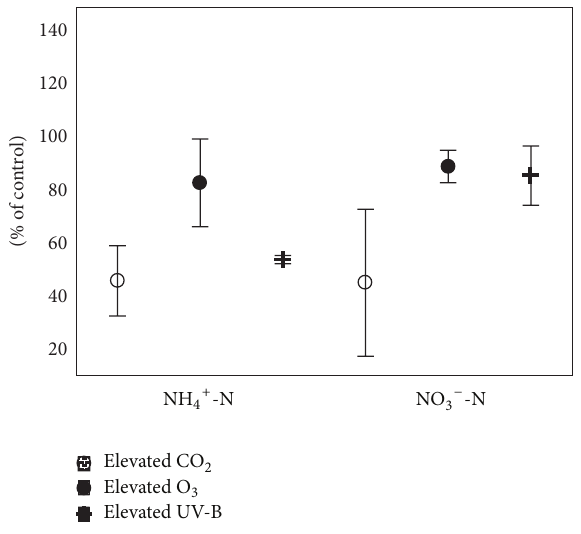
Figure 3: Effect of elevated CO 2 , O 3 , and UV-B on NH 4+ -N and NO 3− -N content in soil (recalculated from [16, 27, 33, 41]). The values are expressed in % of control = 100% which represent ambient CO 2 , O 3 , or UV-B (mean ±